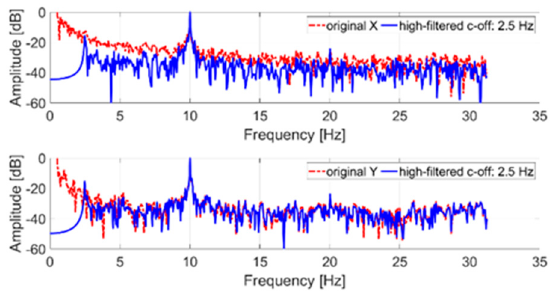
Figure 5. Frequency spectrum of an acquired tremor trajectory (x and y coordinates); in blue, the original signal; in red, the filtered signal.